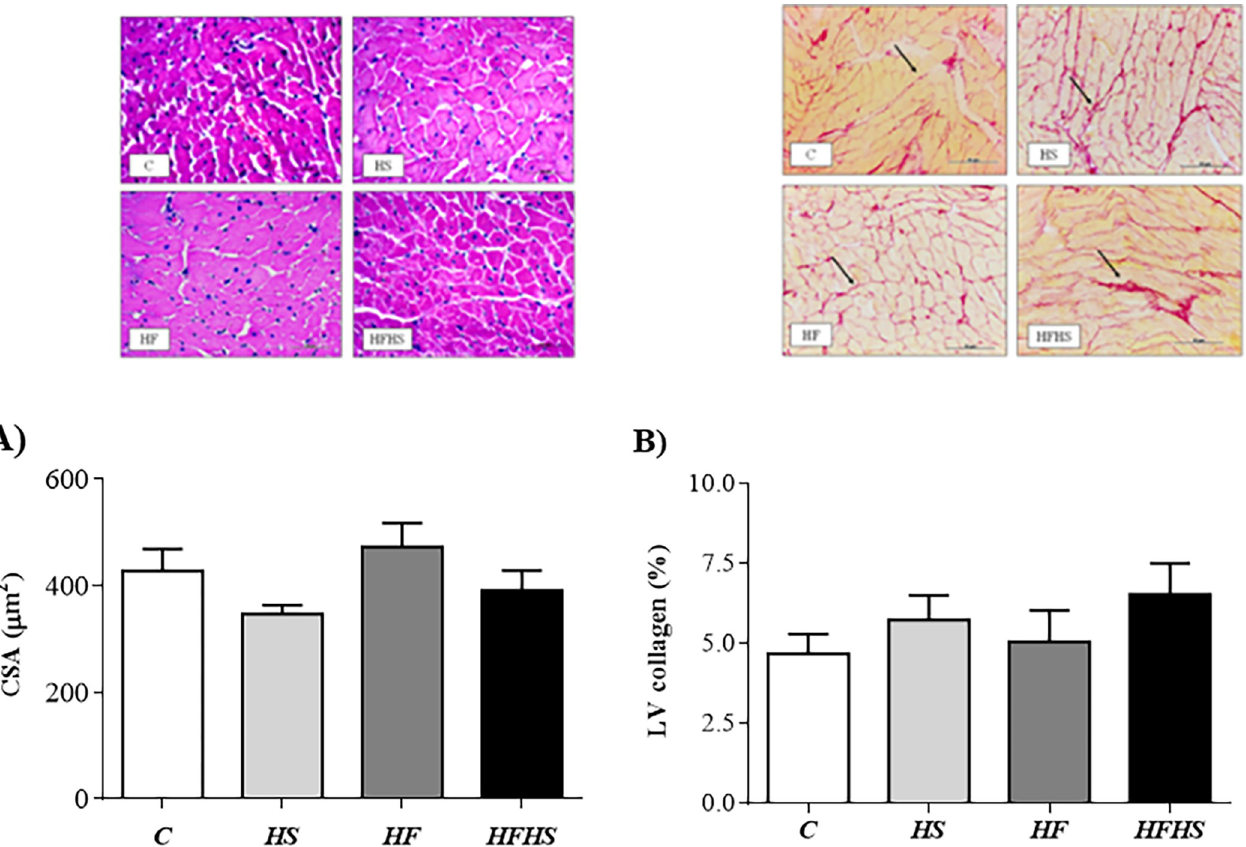
Fig 2. Histological study in myocardium. Control diet—(C; n = 5); high-sugar diet—(HS; n = 8); high-fat diet—(HF; n = 5), and high-fat and high-sugar diet (HFHS; n = 6) after 20 weeks. (A) cross sectional area (CSA). (B): interstitial collagen of myocardium; representative picrosirius red-stained left ventricle (LV) section. Arrows: interstitial collagen. Data are shown as mean ± SEM. One-way analysis of variance (ANOVA) followed by the Tukey post hoc test. p < 0.05 vs. � C; & HFHS vs. HS; §HFHS vs. HF.